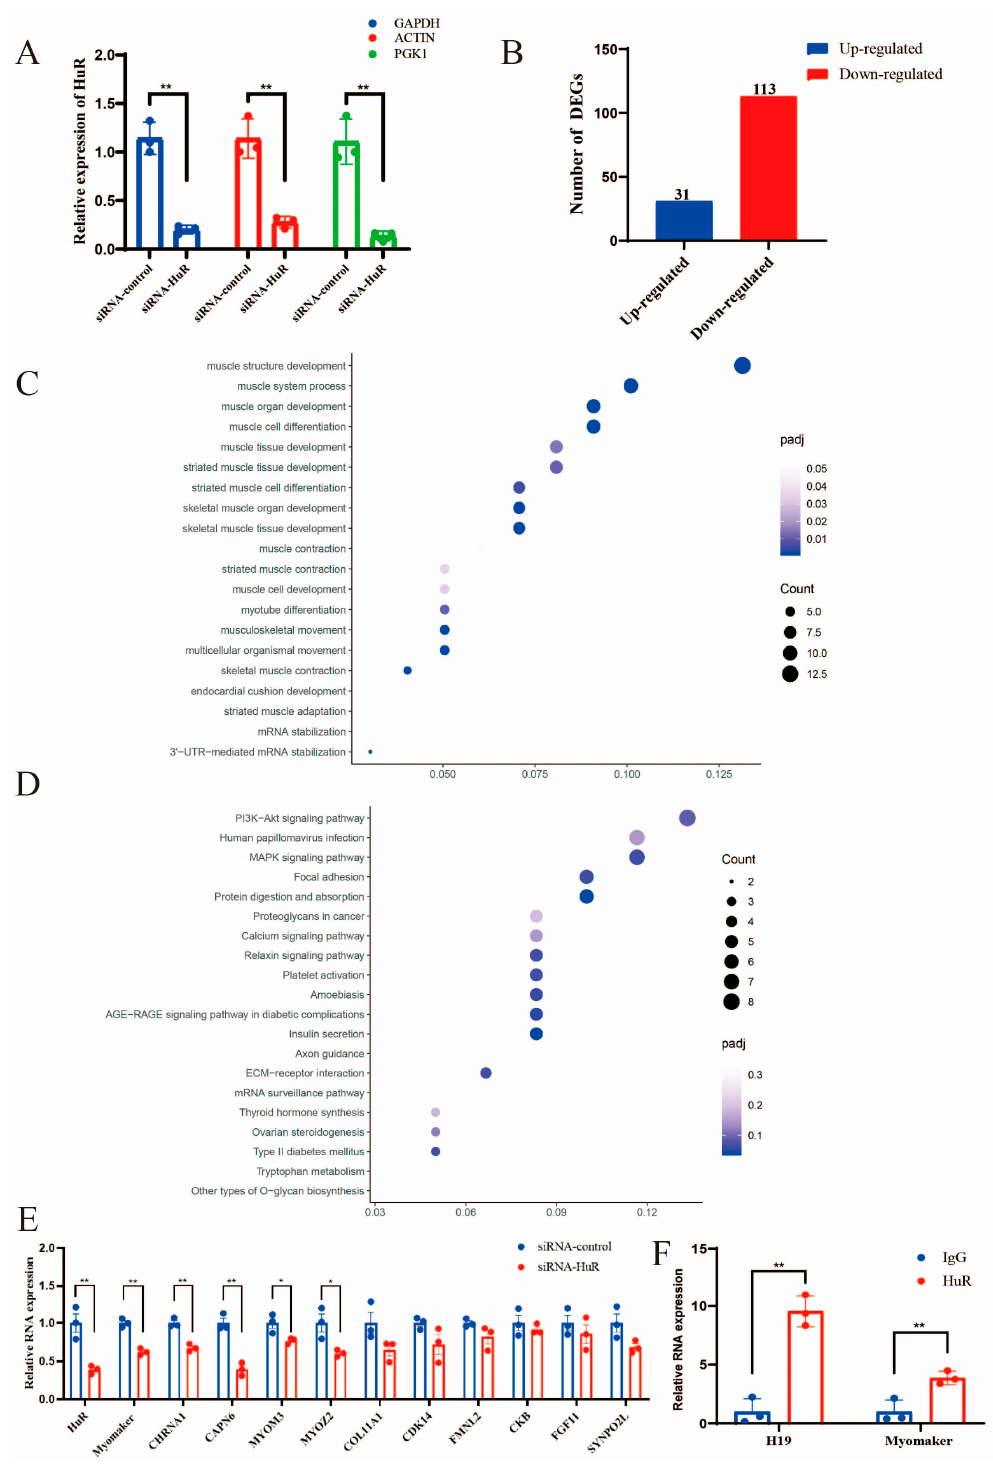
Figure 3. Identification of HuR downstream targets. ( A ) qRT-PCR showed that the expression of HuR in MuSCs transfected with siRNA-control or siRNA-HuR using different reference genes. ( B ) Numbers of upregulated and downregulated DEGs in goat MuSCs. ( C ) GO enrichment analysis of DEGs. ( D ) KEGG pathway enrichment analysis of DEGs. ( E ) qRT-PCR detection of 11 DEGs related to muscle differentiation. ( F ) RIP assay was carried out using HuR antibody, with IgG as the negative control. The H19 group served as a positive control. The data are represented by the average of three independent experiments ± SEM, * p < 0.05, ** p <